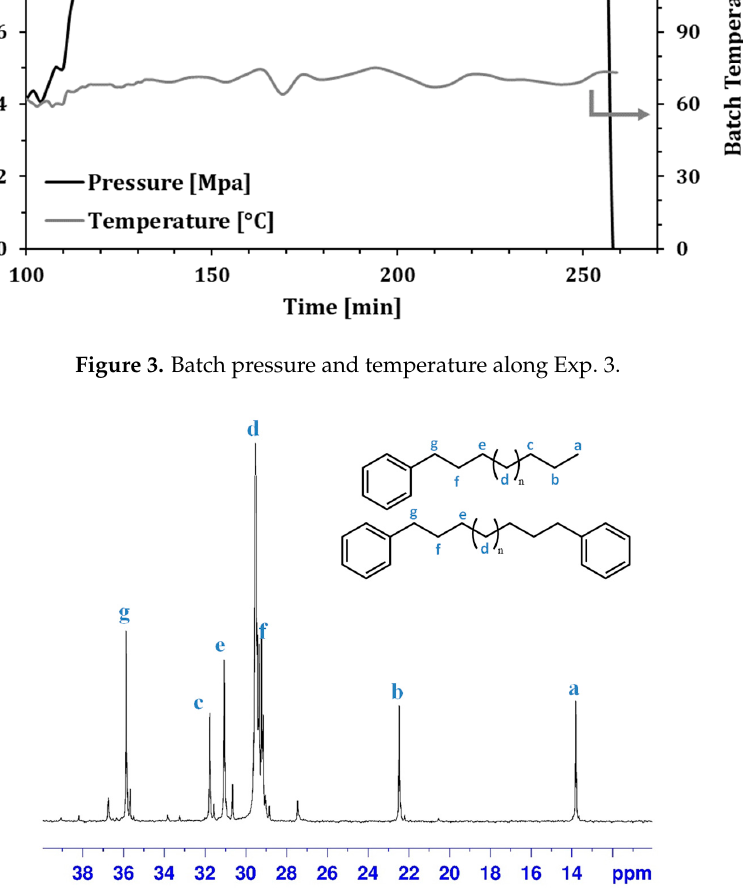
Figure 4. 13 C-NMR spectra of wax produced in Exp. 3 (aliphatic region).